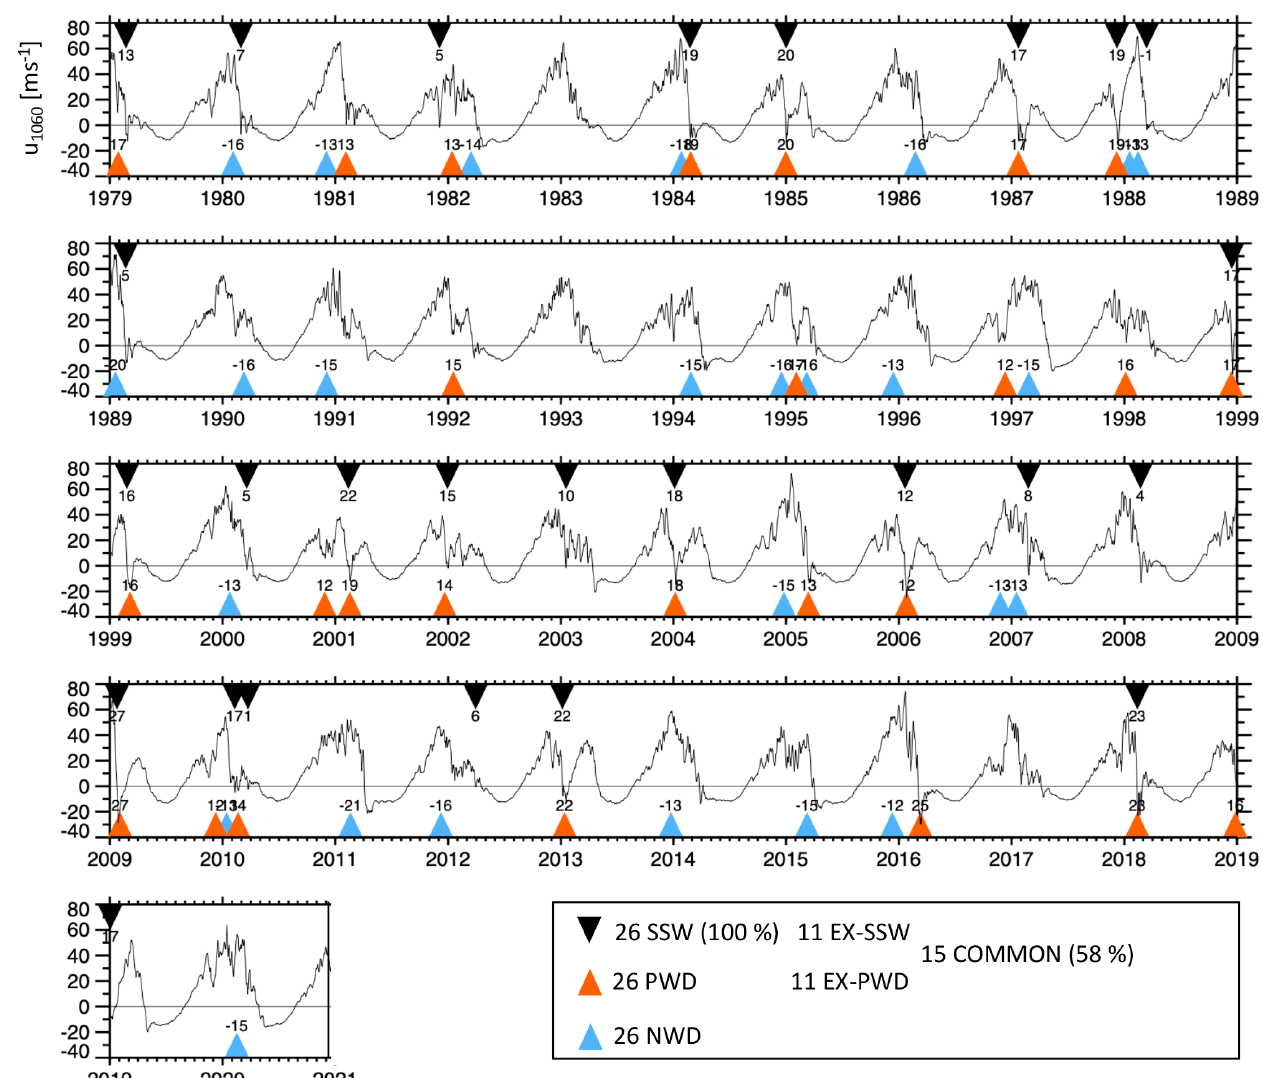
Figure 5. u 1060 time series (meter per second) and history of SSWs, PWDs, and NWDs in ERA5. Horizontal axis shows years; triangles show event day of year (0 = 1 / 1), and small numbers indicate (cid:80) F (cid:48)